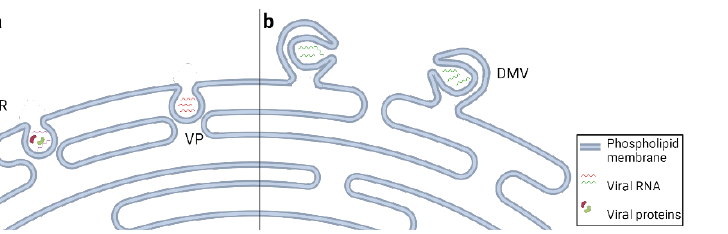
Figure 2. Remodeling of the endoplasmic reticulum (ER) membrane during viral infection. ( a ) Vi- ruses such as Dengue (DENV) and Tick-borne encephalitis virus (TBEV) induce invaginations in the ER known as vesicle packets (VPs). VPs serve as sites for viral genome replication in the case of DENV and as replication and virion assembly in the case of TBEV. ( b ) Genome replication of some coronaviruses and HCV occurs in virus-induced modification of the ER membranes’ double mem- brane vesicles (DMVs). Both VPs and DMVs are used to produce new virions and protect their ge- nomes from cellular nucleases. Created with